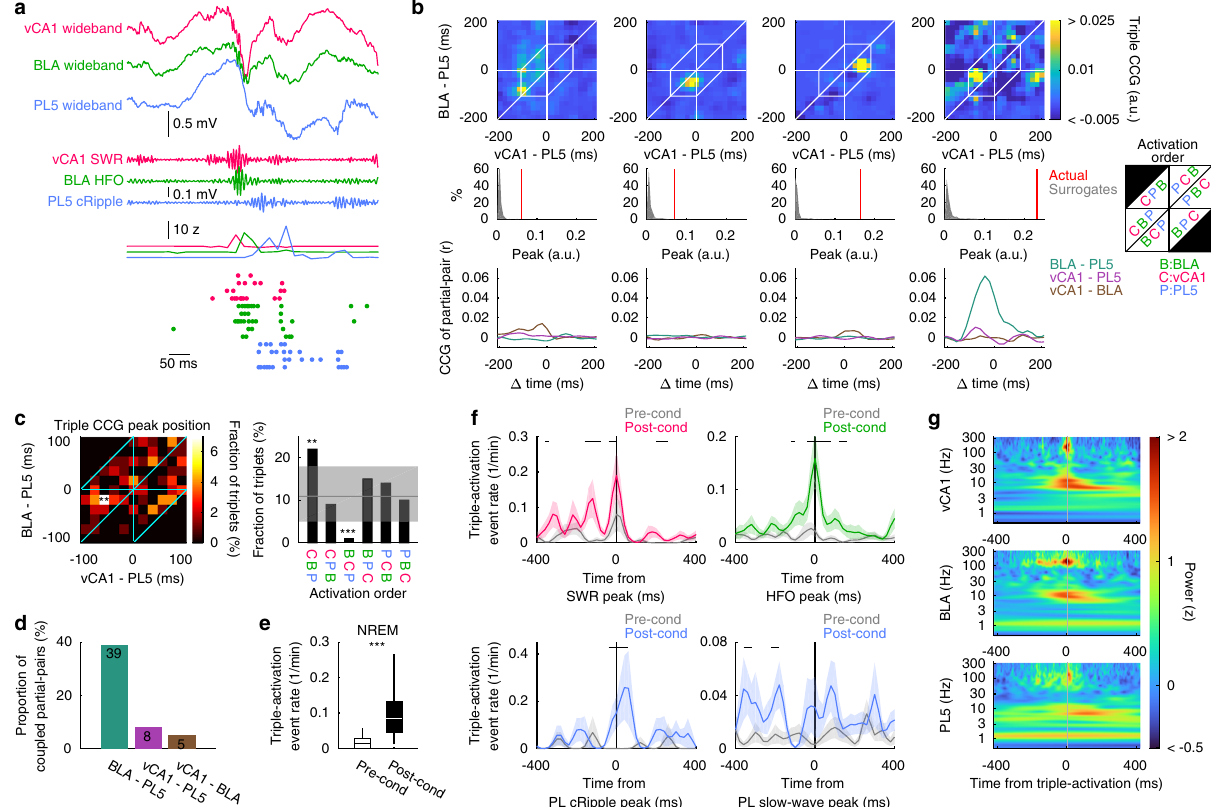
Fig. 6 Triple-activation across the vCA1, BLA, and PL5 during post-cond NREM. a Representative example of triple-activation across vCA1, BLA, and PL5 ensembles. Wideband and fi ltered LFP recorded from the vCA1, BLA, and PL5 are shown at the top. Instantaneous ensemble activation strength and spikes from the member cells of the ensembles are shown at the bottom. b Representative examples of triple CCGs (top), distribution of triple CCG peak height of the surrogates and the peaks of the actual data (middle), and CCGs of participating ensemble pairs (partial-pairs; bottom). The white hexagons on the top panels indicate the range of peak detection (time gaps of all combinations <100 ms). The leftmost panel illustrates the triplet shown in ( a ). The inset on the right illustrates the order of ensemble activation. c Distribution of triple CCG peak position (left) and ensemble activation order (right) across coupled- ensemble-triplets. The peak distribution is non-uniform ( p < 0.001, χ 2 test) with a signi fi cant peak (** p < 0.01, based on Poisson distribution with Bonferroni correction). The grey line and shaded areas on the right panel indicate the mean and 95% con fi dence interval, respectively, assuming uniform distribution. *** p < 0.001, ** p < 0.01, test based on Poisson distribution with Bonferroni correction. d The proportion of the partial-pairs of coupled-ensemble- triplets with signi fi cant peaks on their CCG during post-cond NREM. The numbers of partial-pairs are superimposed on the bars. e Box plots indicating the BLA – vCA1 – PL5 triple-activation event occurrence rate per coupled-ensemble-triplet. The centre lines and limits of the boxes represent the median and quartiles, respectively, and whiskers extend to the maxima and minima with outliers excluded. *** p < 0.001, WSR-test. f Oscillatory event peak-triggered average of triple-activation event rates of coupled-ensemble-triplets. The lines and shaded areas indicate the means and SEMs, respectively. Periods with signi fi cant differences between pre- and post-cond are indicated with black ticks on the top ( p < 0.05, WSR-test). g Triple-activation event-triggered average of wavelet power in the vCA1, BLA, and PL5. The numbers of ensemble triplets analysed are summarised in Supplementary Table 4. Detailed statistics are shown in Supplementary Data 1. Source data are provided as a Source Data fi